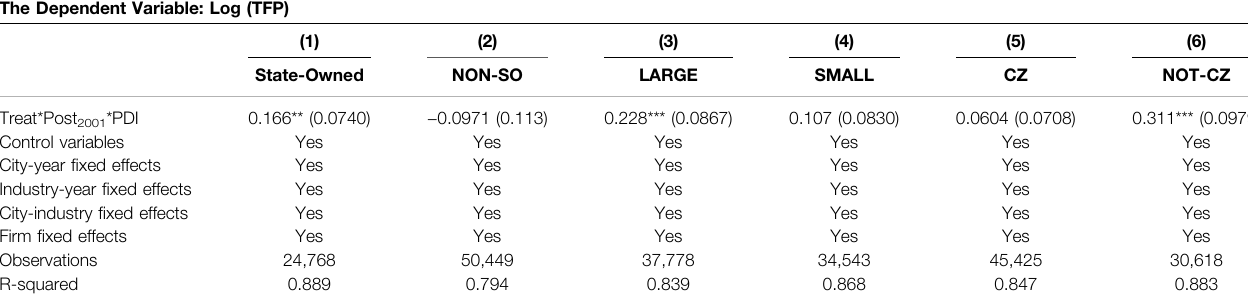
TABLE 4 | Testing for heterogeneous